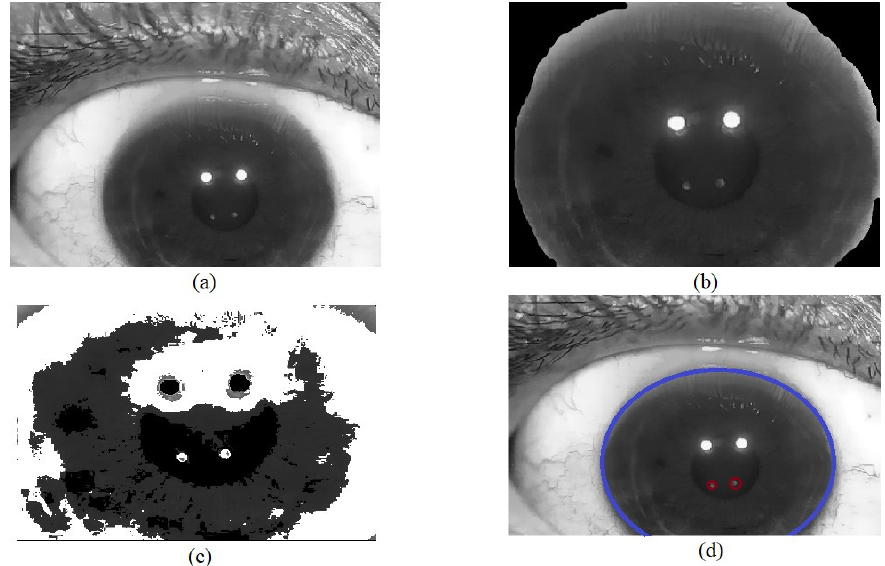
Figure 7. Segmentation process once the PIV image of Purkinje is formed: ( a ) image obtained from the wave-front sensor; ( b ) iris zone segmentation; ( c ) applying a threshold and noise removal algorithm to eliminate unwanted areas in the image; ( d ) detection of PIV in the pupil area.